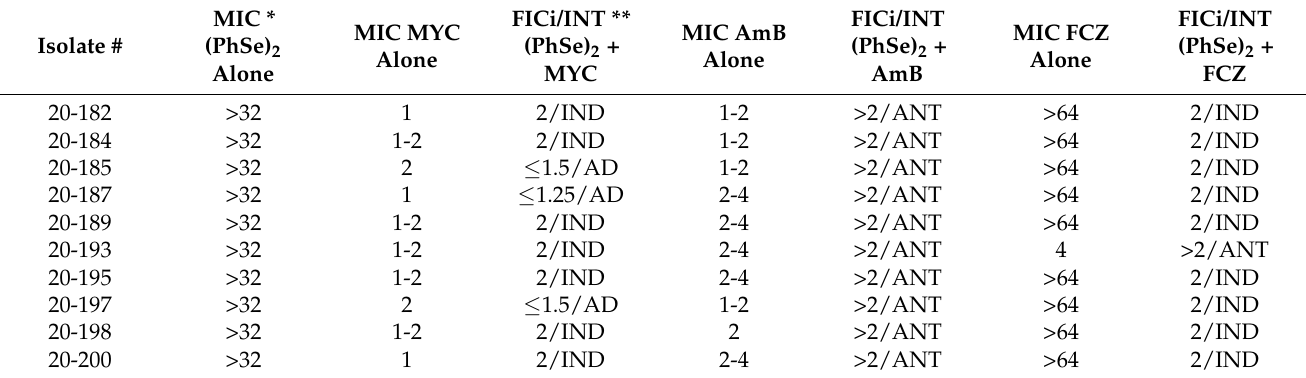
Table 1. Results of minimal inhibitory concentration (MIC) of alone drugs and fractional